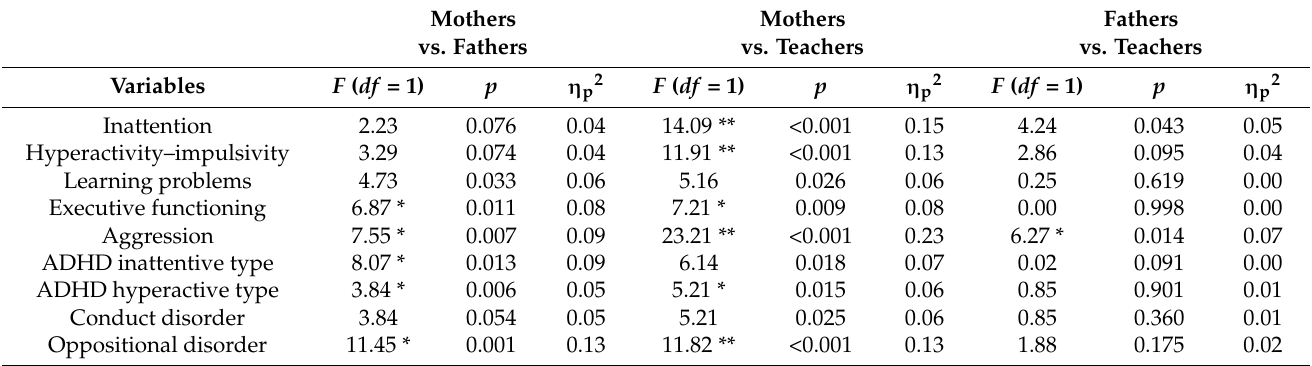
Table 5. Comparison of respondents to the Conners 3 content and symptom scales for all groups combined. Mothers vs. Fathers